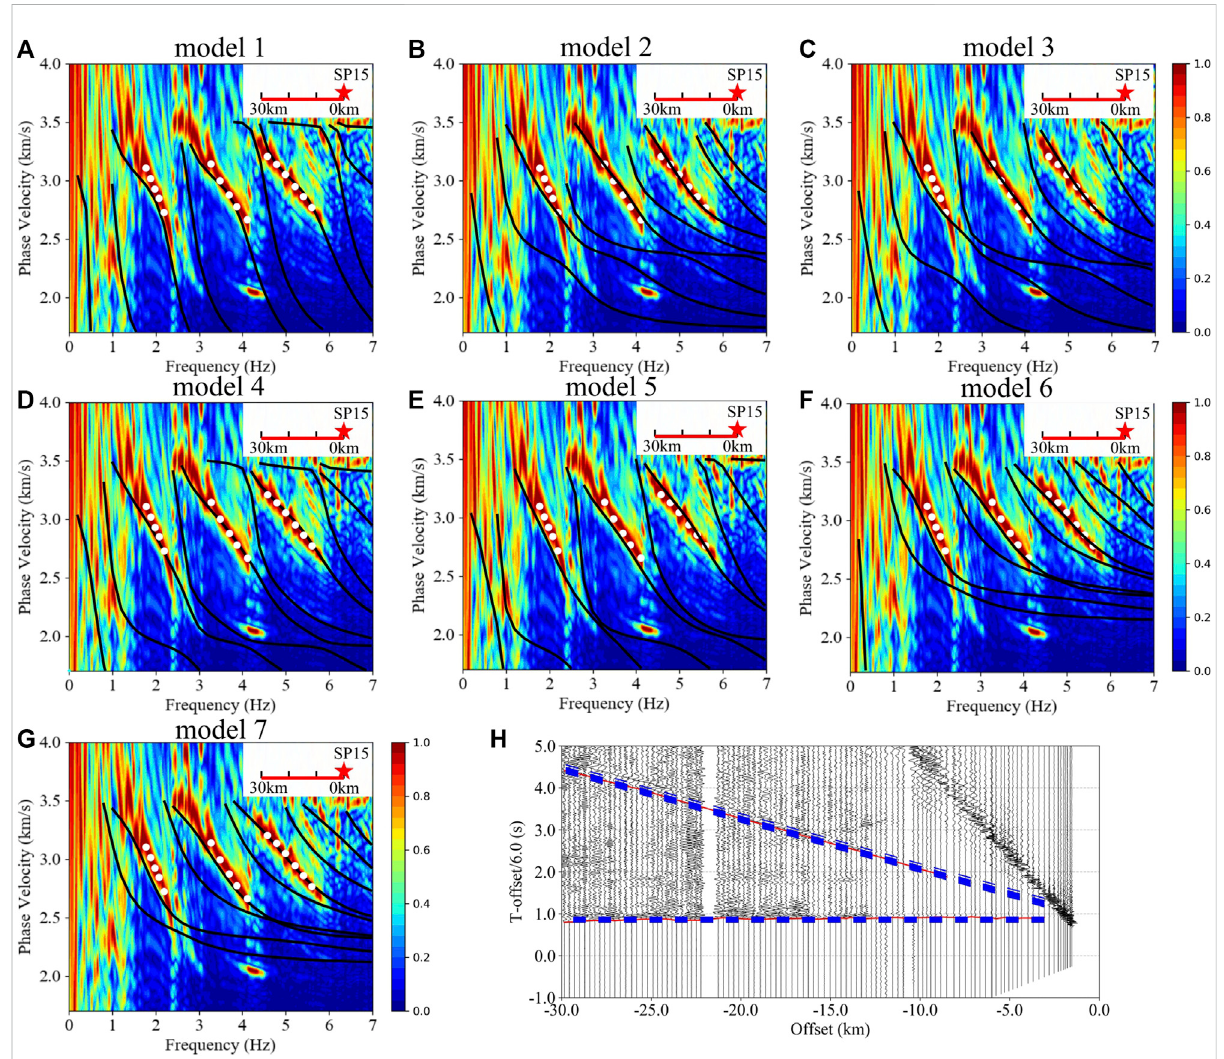
FIGURE 7 The results of the joint Monte Carlo inversion with the multimodal dispersion curves and the Pg and Sg travel times from the SP15 seismic data. In the upper right corner of (A – G) , the red star represents the source, and the F-J spectrogram is extracted from the seismic data on the red line. (A – G) arethedispersion curves oftheacceptedmodelsone toseven inTable2. (H) Theredlines arethepickedPgandSg, andthebluedashedlines are the calculated Pg and Sg of the accepted models in Table